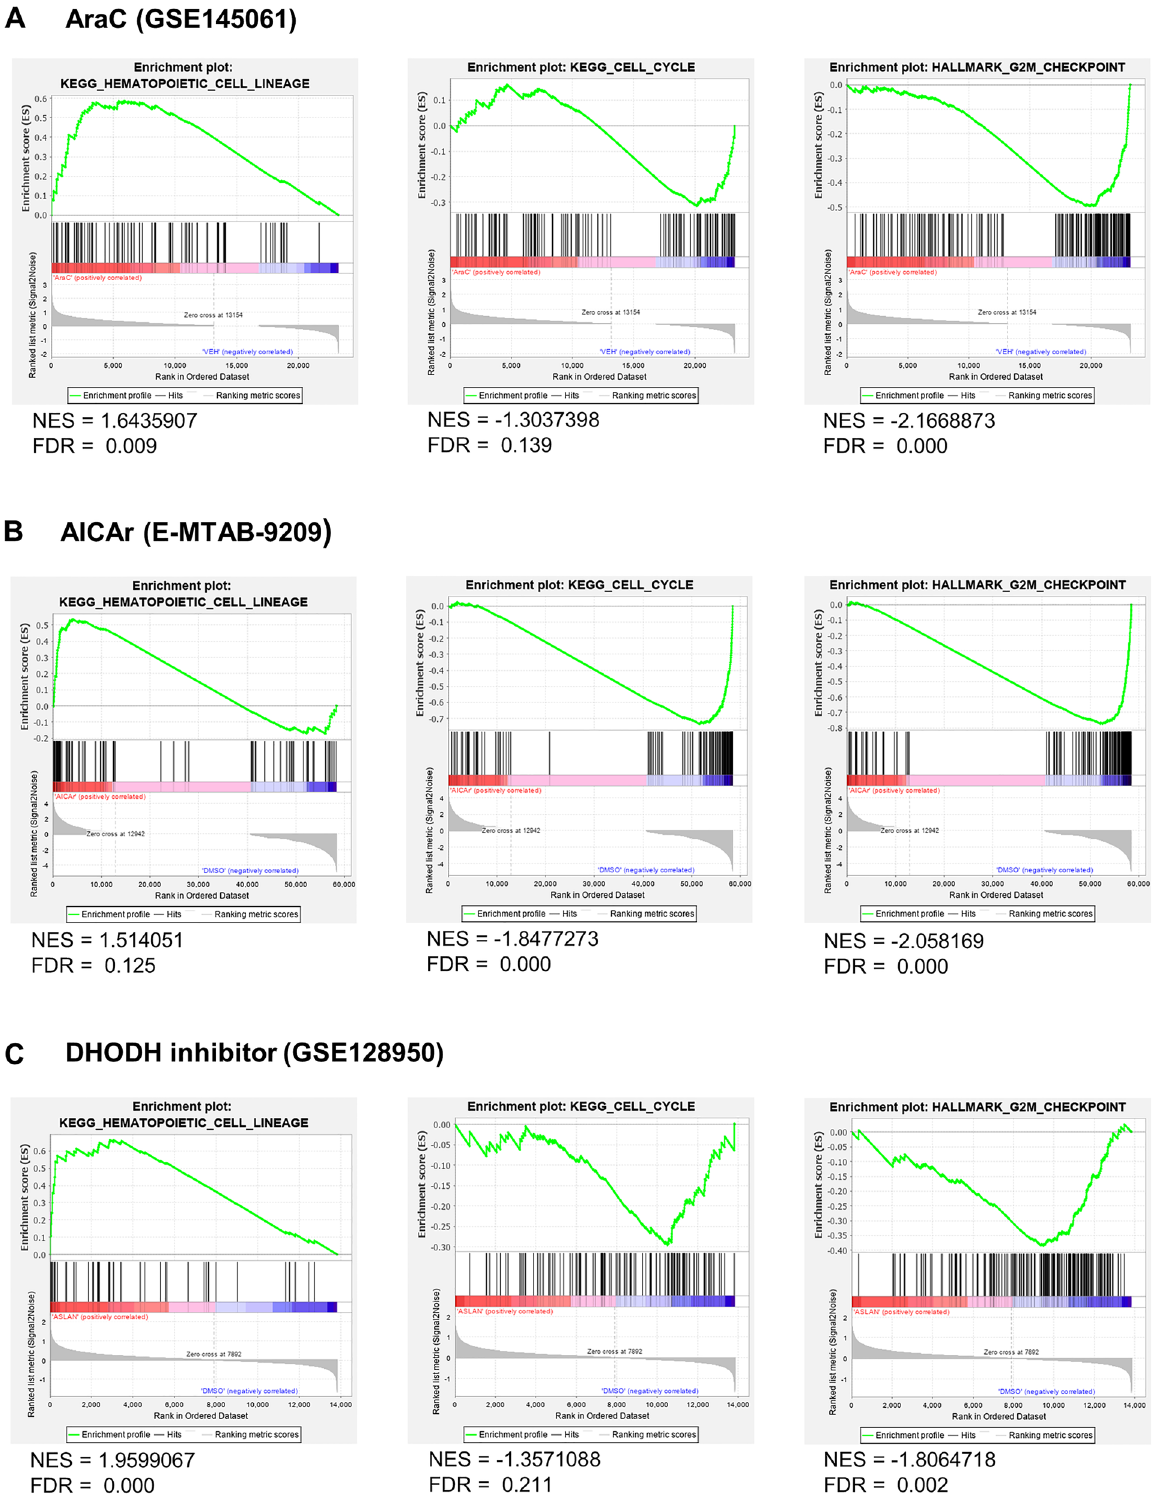
Figure 8. Cytarabine and pyrimidine synthesis inhibitors have similar effects on transcriptional signatures. ( A ) Gene set enrichment analysis of RNASeq read counts from two patient samples treated with 1000 nM AraC in vitro for 24 h. ( B ) Gene set enrichment analysis of RNASeq read counts from AML-M2 patient that was responsive to pyrimidine synthesis inhibition (Pt 14, normal karyotype, FLT3 wt, NPM wt) treated with 0.4 mM AICAr for 24 h. ( C ) Gene set enrichment analysis of RNASeq read counts from MOLM-14 and KG-1 cells treated with a novel DHODH inhibitor ASLAN003 (0.5 and 1 µM) for 24 h (GSE128950). Enrichment plots are shown for KEGG pathways Hematopoietic Cell Lineage and Cell Cycle, and MSigDB G 2 /M Checkpoint